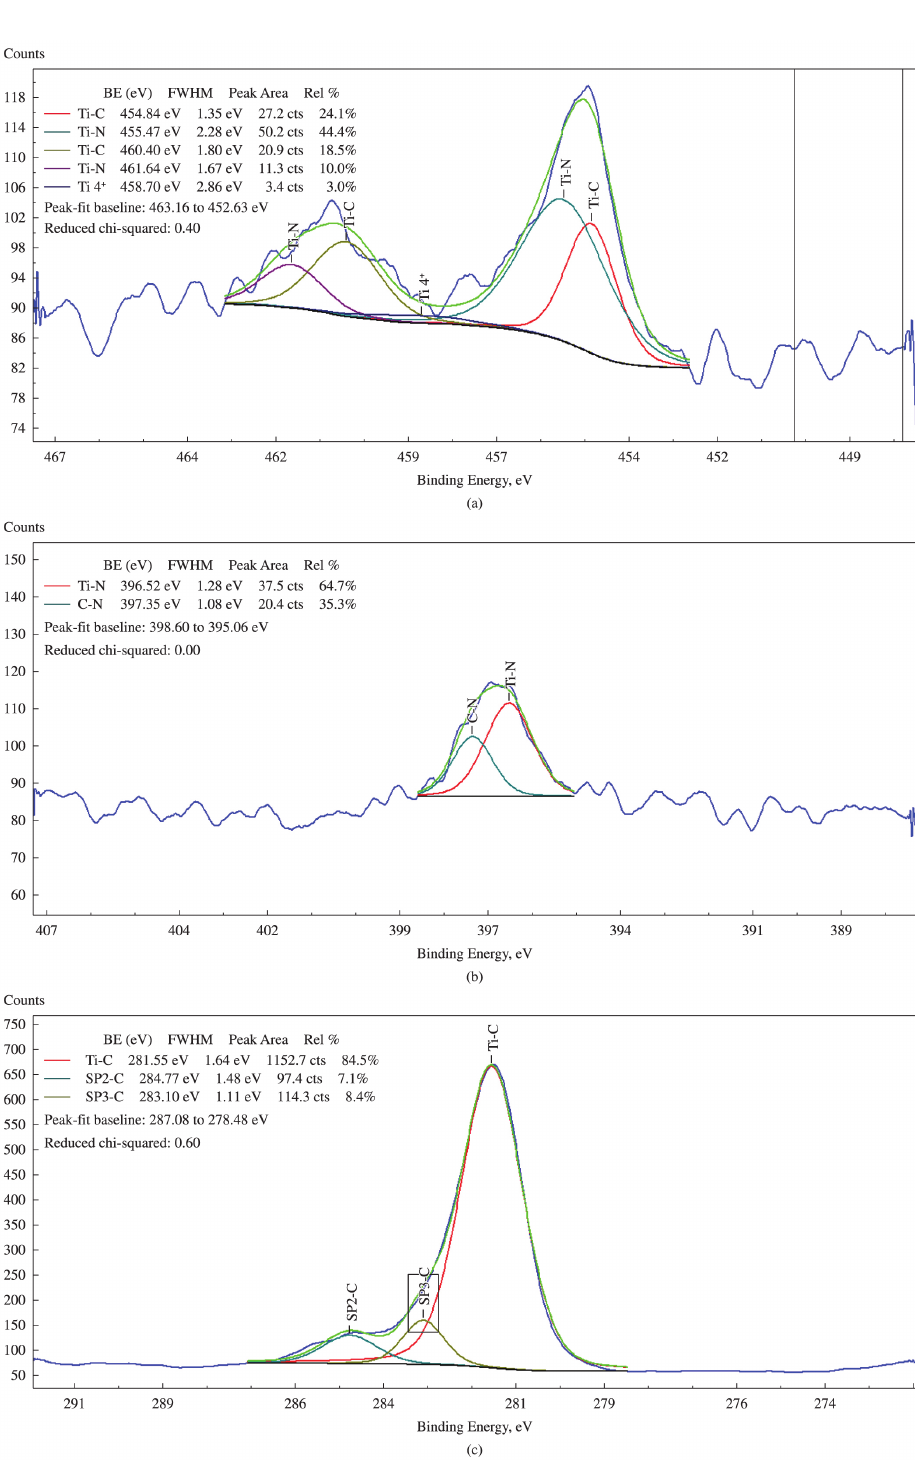
Figure 3. XPS spectra of a)Ti 2p, b)N 1s and c)C 1s for the film for CH4/ (CH4+N2) gas flow ratio